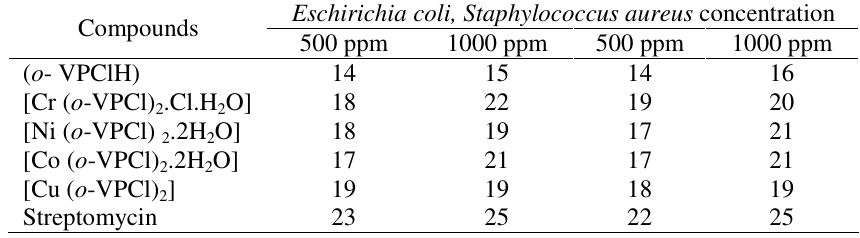
Table 5. Antibacterial activity of the Schiff base ligand and their metal complexes, showing of diameter of inhibition zone